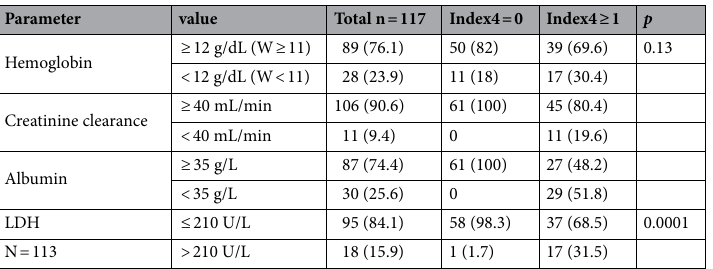
Table 2. Laboratory parameters in the groups of Index4 = 0 and ≥ 1. The last column depicts Fisher’s exact test p values. Creatinine clearance and albumin are among the parameters for the calculations of Index4 and thus, by definition, no patients had creatinine clearance below 40 mL/min or albumin below35 g/L in the Index4 = 0 group. Percentages are in parentheses.